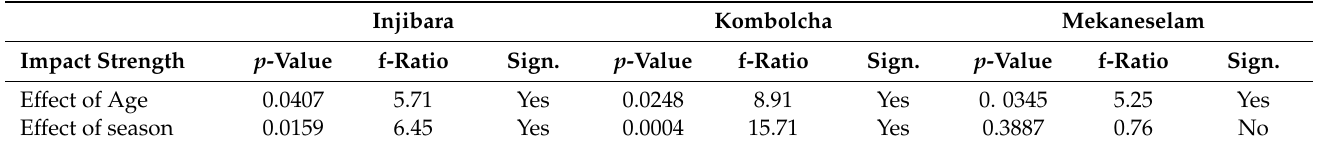
Table 4. ANOVA test results of impact strength on the effect of ages and harvesting seasons. Injibara Kombolcha